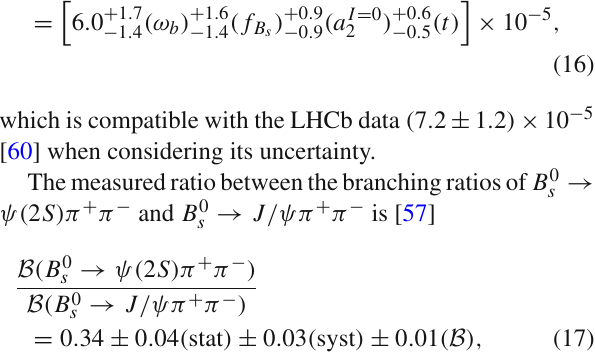
M B = 5 . 367 , m ψ( 2 S ) = 3 . 686 , m ψ( 3 S ) = 4 . 040 , m π = 0 . 14 , m b = 4 . 2 , m c = 1 . 27